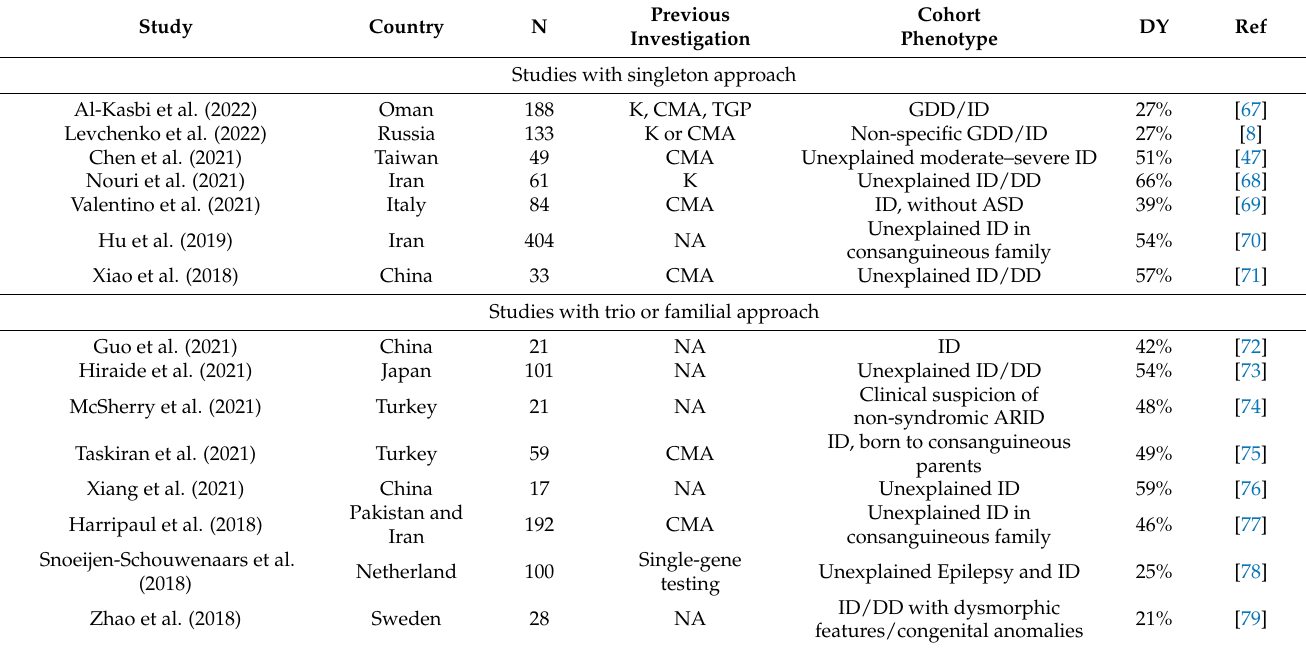
Table 5. Exome sequencing of individuals with intellectual disabilities/developmental disabilities in recent